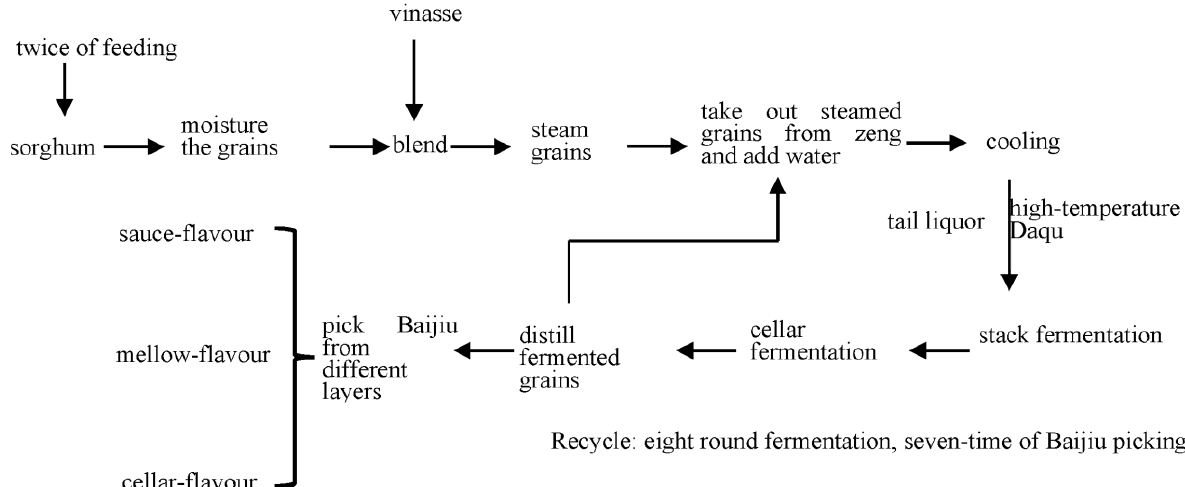
Figure 4. Flow chart of the brewing process of Sauce-aroma Baijiu.